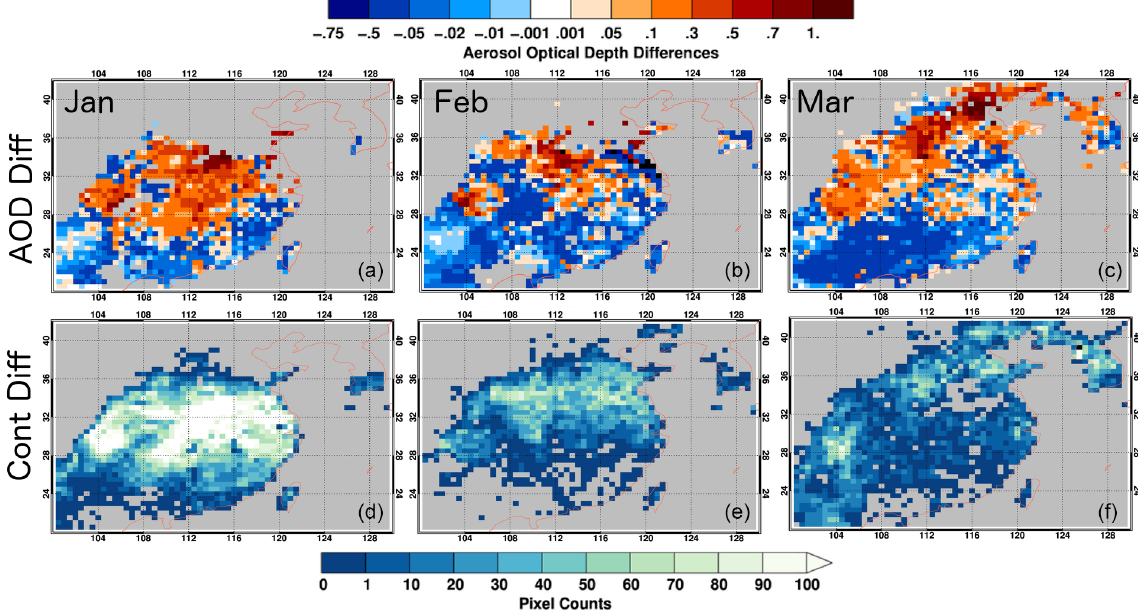
Figure 14. Spatial distribution of AOD differences (a–c) and number of data point differences (d–f) between the operational product and the research product (research minus operational) at 0.5 ◦ resolution over the study domain from January to March